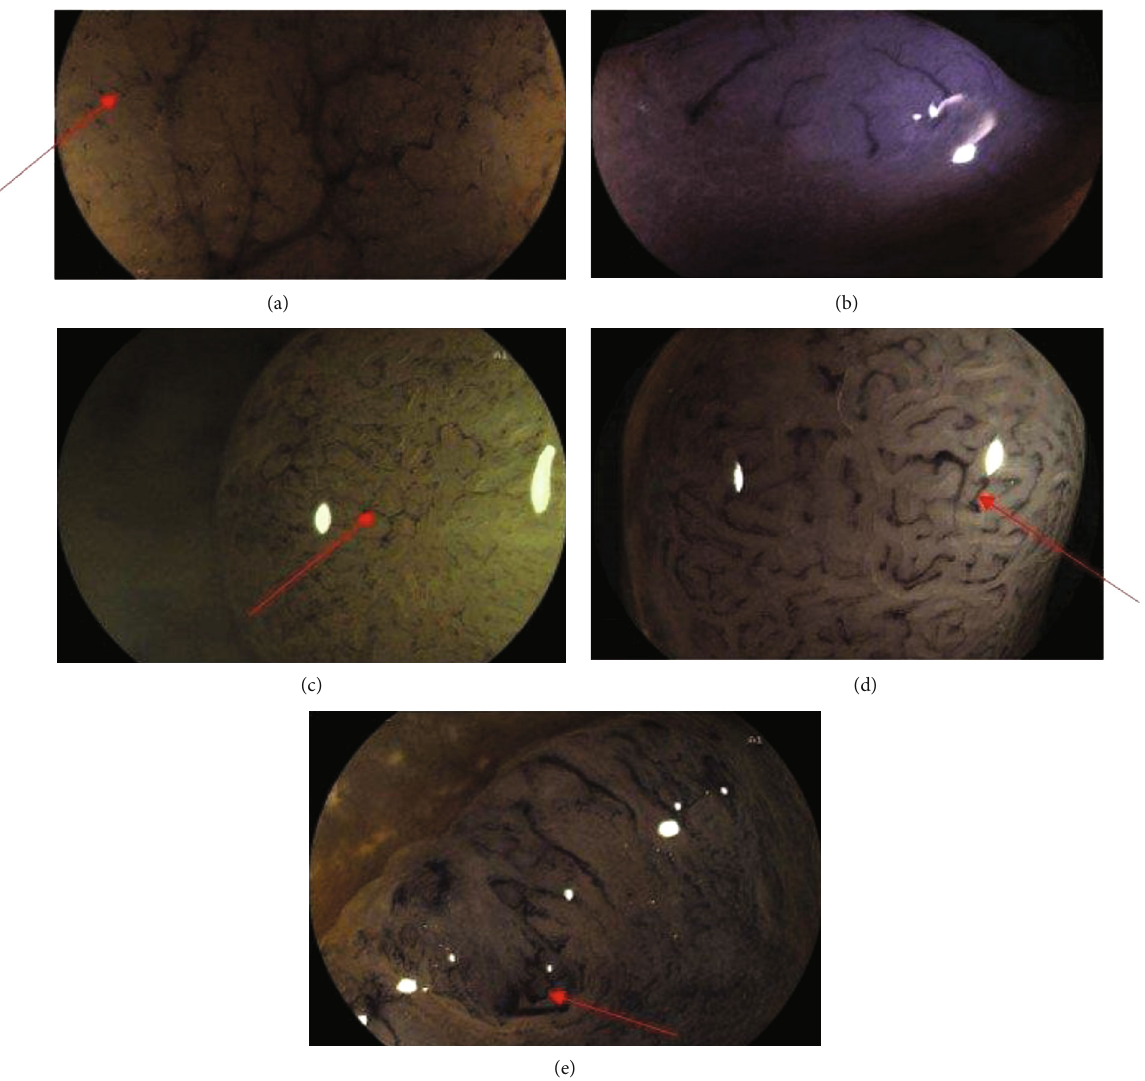
Figure 1: Endoscopic capillary-vessel pattern classi fi cation (Teixeira et al.) [5]. (a)Type I: normal pattern composed of thin subepithelial capillary vessels with a linear shape and regular arrangement surrounding the mucosal crypts. (b).Type II: this pattern exhibits hypovascularity or marginal capillaries of a thicker diameter, curved, or straight but uniform, without dilatations, and the pericryptal arrangement is not remarkable. (c).Type III: numerous capillaries of thinner diameter, irregular and tortuous, with frequent point dilatations, and tapering like a spiral shape, showing remarkable periglandular arrangement. (d).Type IV: numerous long, spiral, or straight blood vessels with a thicker diameter, and sparse dilatations, running upright, surrounding the villous glands. (e).Type V: pleomorphism of capillaries and abnormal distribution and arrangement; numerous heterogeneous thick vessels with chaotic arrangement are the